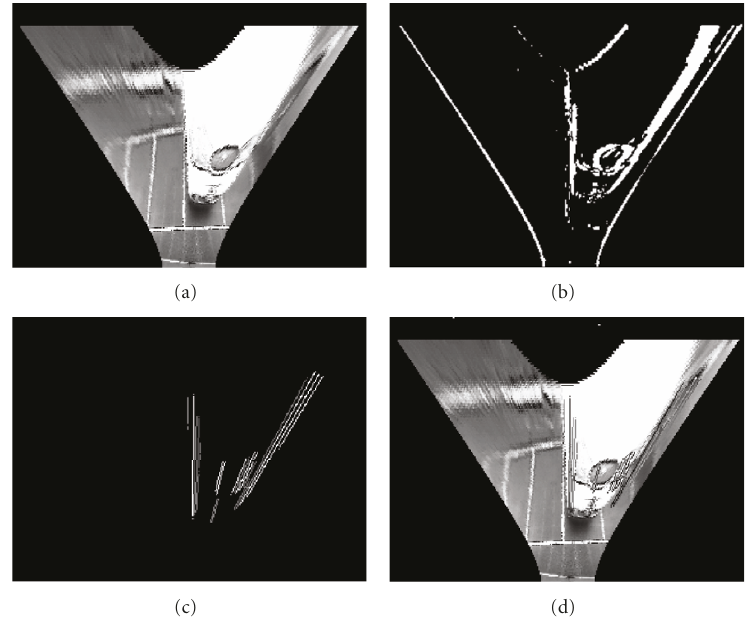
Figure 13: The results of the feature searching procedure using temporal di ff erence FLIPM images, (a) the remapped image, (b) the temporal di ff erence FLIPM image, (c) the scanned feature segments, (d) the scanned feature segments superposed on the remapped